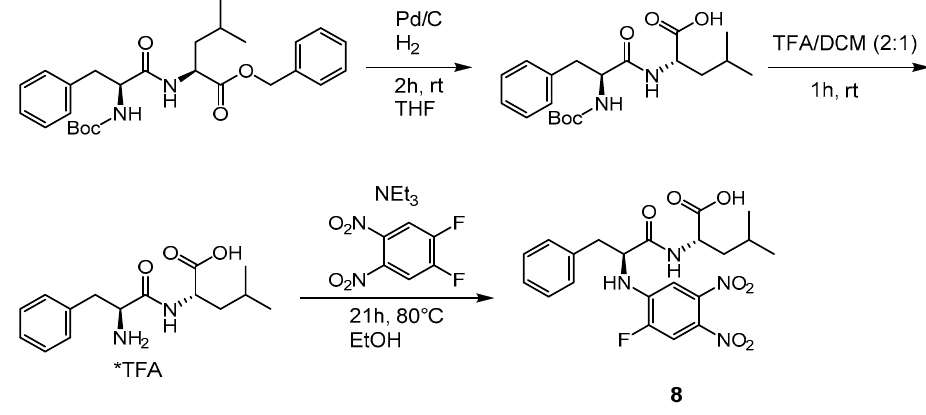
Table 1. Inhibition data for inhibitors of the general structure R-NH- L -Phe- L -Leu-OBn, % inhibition at 20 µM and K i [µM]. 1.